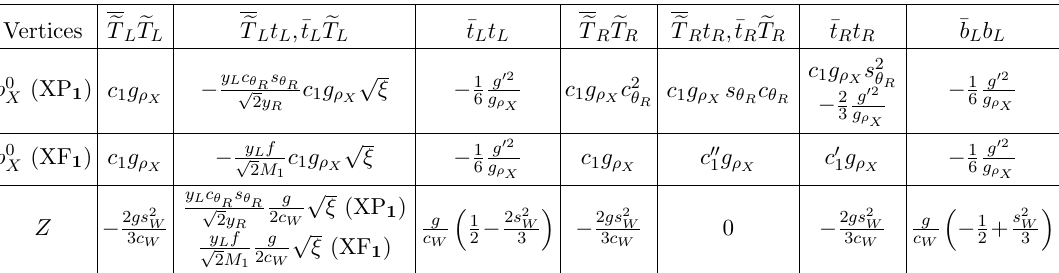
and Z , and the X